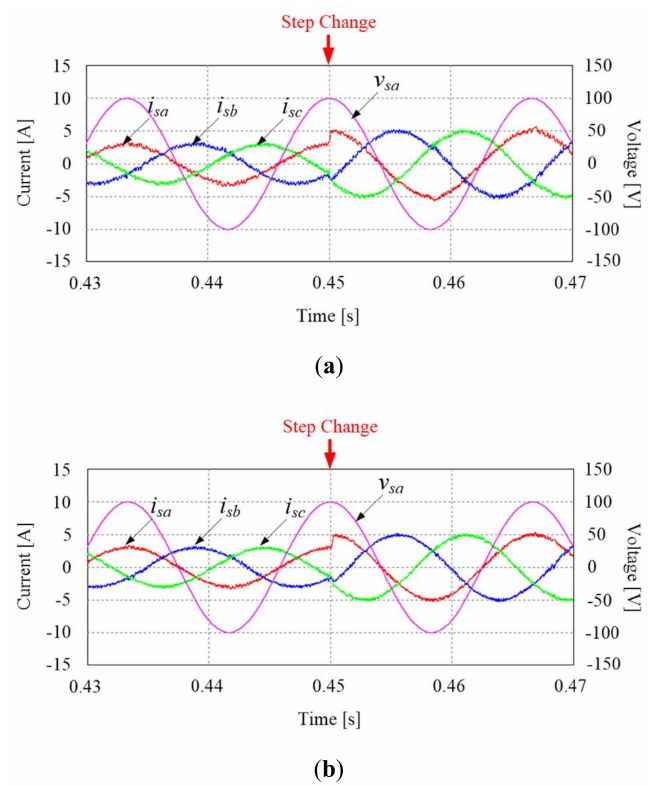
Figure 9. Simulation results of three-phase source currents and a -phase source voltage for the source current magnitude step change from 3 A to 5 A obtained from ( a ) the conventional algorithm and ( b ) the proposed